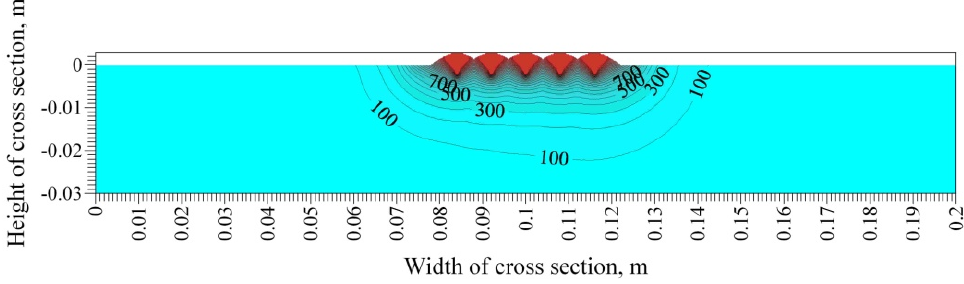
Figure 14. Maximum temperatures (°C) in the cross ‐ section of surfaced plate.